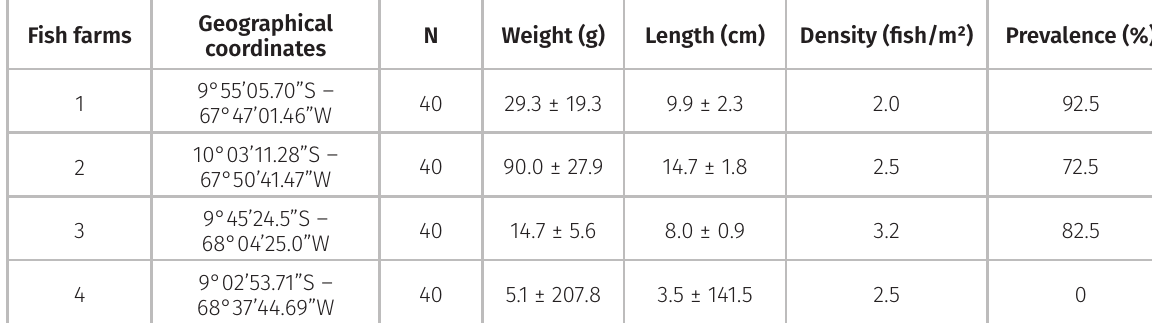
Table I. Localization, body parameters, stocking density and overall prevalence of parasites in Leporinus macrocephalus of four fish farms from Rio Branco, in State of Acre, western Amazon region (Brazil). Fish